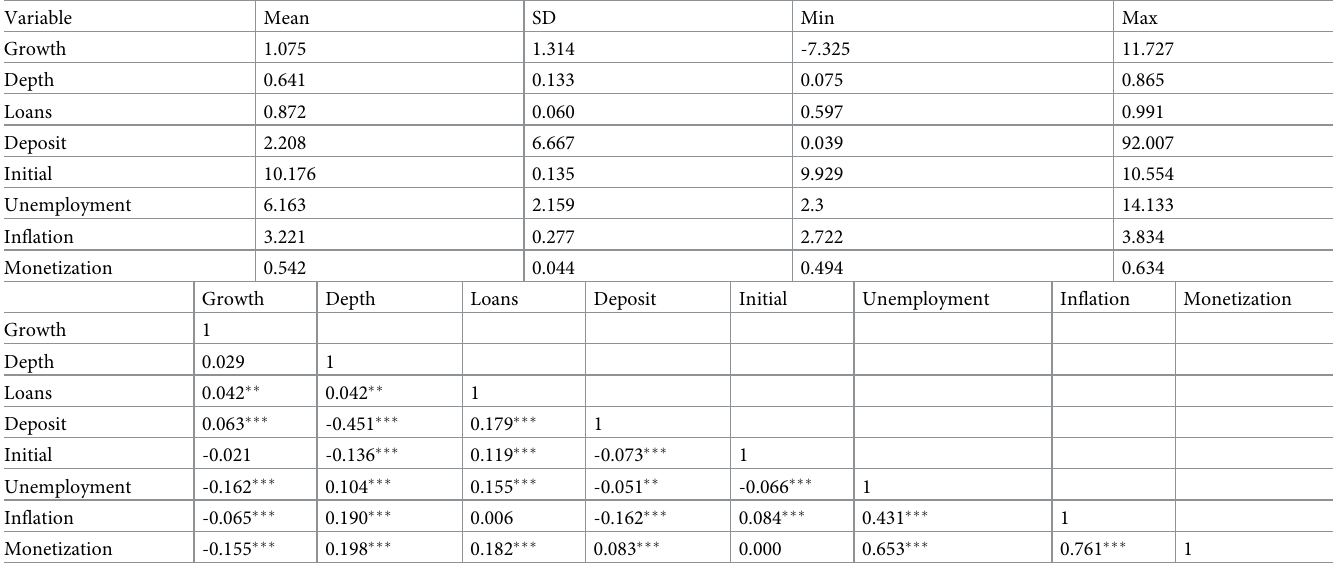
Table 1. Data description statistics and